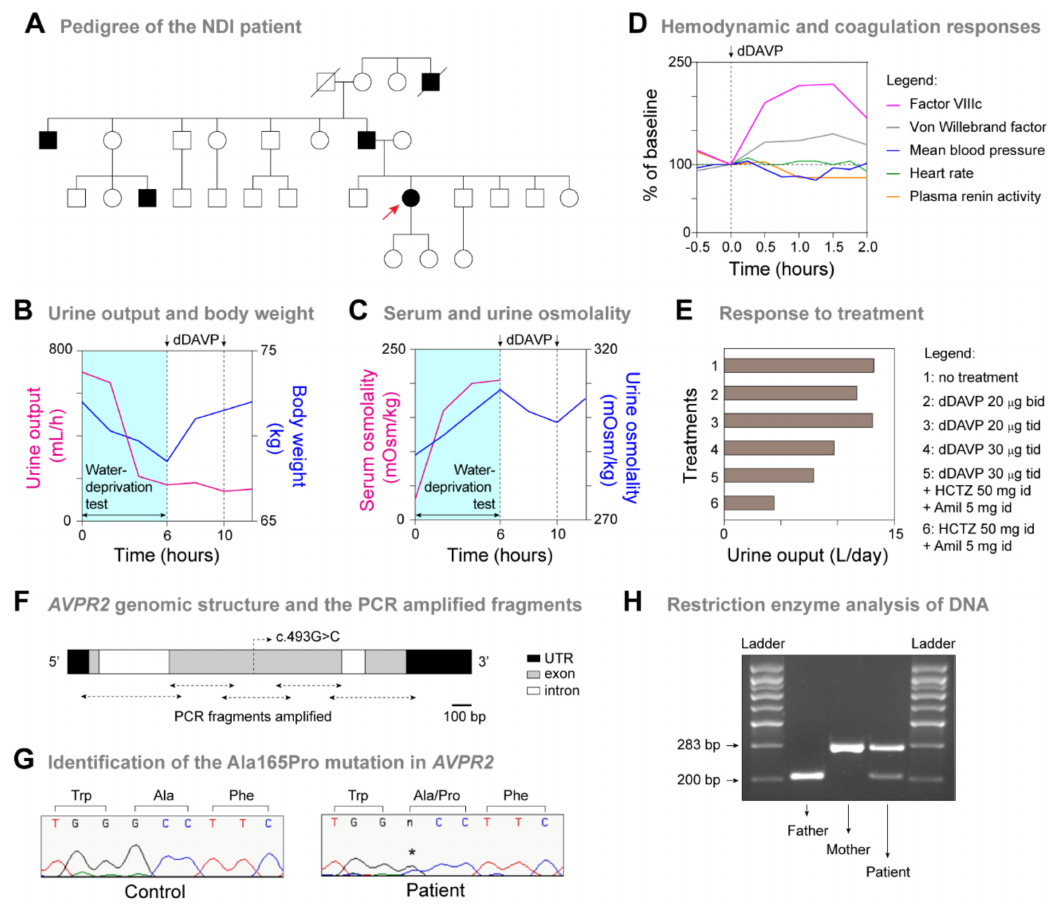
Figure 1. Biochemical and genetic studies of the patient with nephrogenic diabetes insipidus (NDI). ( A ) Pedigree of the patient with NDI. The inheritance follows a typical X-linked recessive pattern, apart from the reported female patient (red arrow). Individuals are represented as males (squares), females (circles), affected (filled symbol), unaffected (open symbol) and deceased (oblique line through symbol). ( B , C ) Water-deprivation and dDAVP stimulation tests. The water-deprivation test was continued until the patient lost 5% of her body weight, which occurred after 6 h ( B ). At the end of the test, serum osmolality had increased from 276 to 311 mOsm/Kg (normal 275–295) and the urine osmolality had increased from 95 to only 191 mOsm/Kg (normal 300–900) ( C ). Arrows indicate the administration of dDAVP (2 µ g intramuscular injection), which did not increase urine osmolality, thereby supporting the diagnosis of NDI. ( D ) Extra-renal responses to dDAVP. Arrow indicates the administration of dDAVP (0.3 µ g/kg, intravenous infusion over 20 min). Mean arterial blood pressure decreased 18% (normal > 10%), heart rate increased 10% (normal > 20%), plasma renin activity increased 4% (normal > 65%), factor VIIIc increased 2.2 × (normal > 3 × ), von Willebrand factor increased 1.5 × (normal > 2 × ). ( E ) Response to treatment. Treatment with increasing doses of dDAVP did not significantly improve the polyuria. Treatment with hydrochlorothiazide (HCTZ) 50 mg bid, amiloride chloridrate (Amil) 5 mg bid and a low-sodium diet, resulted in a reduction of diuresis to approximately 5 L/day. ( F ) Genomic structure (Xq28) showing the exons (grey boxes), introns (white boxes), 3 (cid:48) - and 5 (cid:48) - untranslated regions (UTR) (black boxes) of the AVPR gene. The locations of the PCR amplified fragments and the identified mutation are shown. ( G ) Partial DNA sequencing of exon 2 of the AVPR2 gene in the patient and a control. We identified a novel heterozygous missense mutation (c.493G > C, p.Ala165Pro; noted by an asterisk) in the patient. ( H ) Agarose gel electrophoresis of Mwo I-digested PCR fragments. The mutation creates a restriction site for this enzyme, resulting in fragments of 200 base pairs (bp) and 83 bp (not shown), whereas the normal allele results in fragments of 283 bp. The patient is heterozygous for the mutation, the father is hemizygous and the mother is homozygous for the normal allele. We used a 100 bp ladder as a DNA size